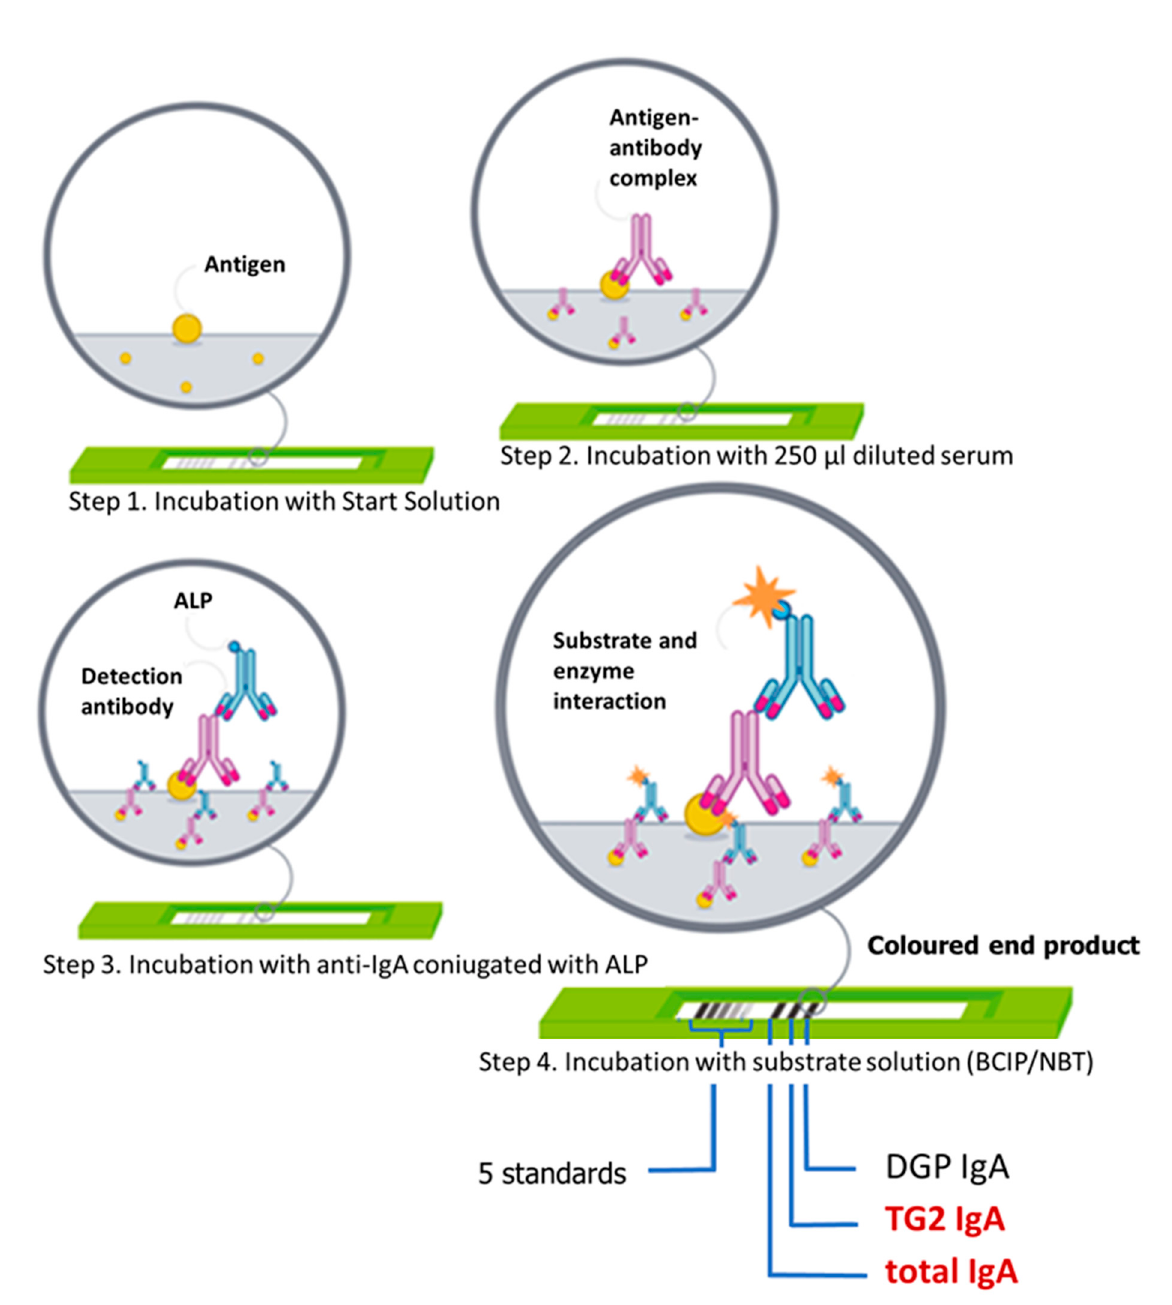
Figure 1. Schematic steps of the multiparametric immunoassay quantitative test Polycheck ® Celiac IgA plus total IgA (Biocheck, GmbH, Münster, Germany). BCIP/NBT = 5 ′ bromo-4 ′ chloro-3 ′ indol- ylphosphate/4 ′ nitrobluetetrazolium; ALP = alkaline phosphatase.